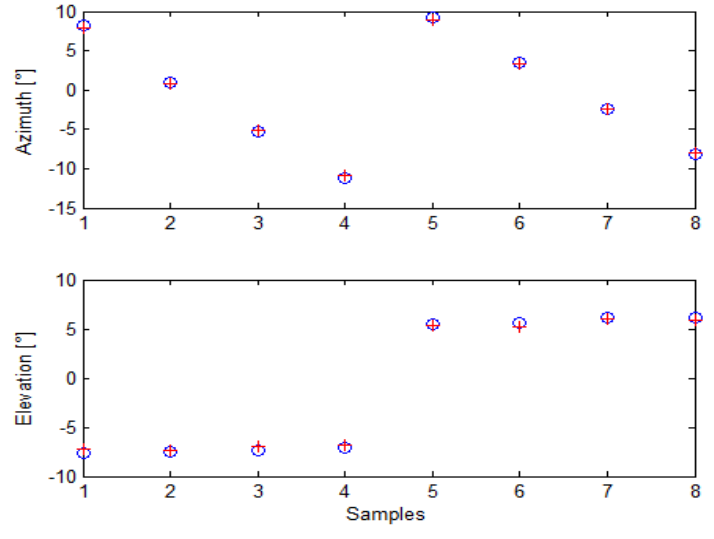
Figure 11. Target angular positions as extracted from images (blue circles) and from GPS/AHRS measurements and computed rotation matrix (red crosses) for the infrared camera.